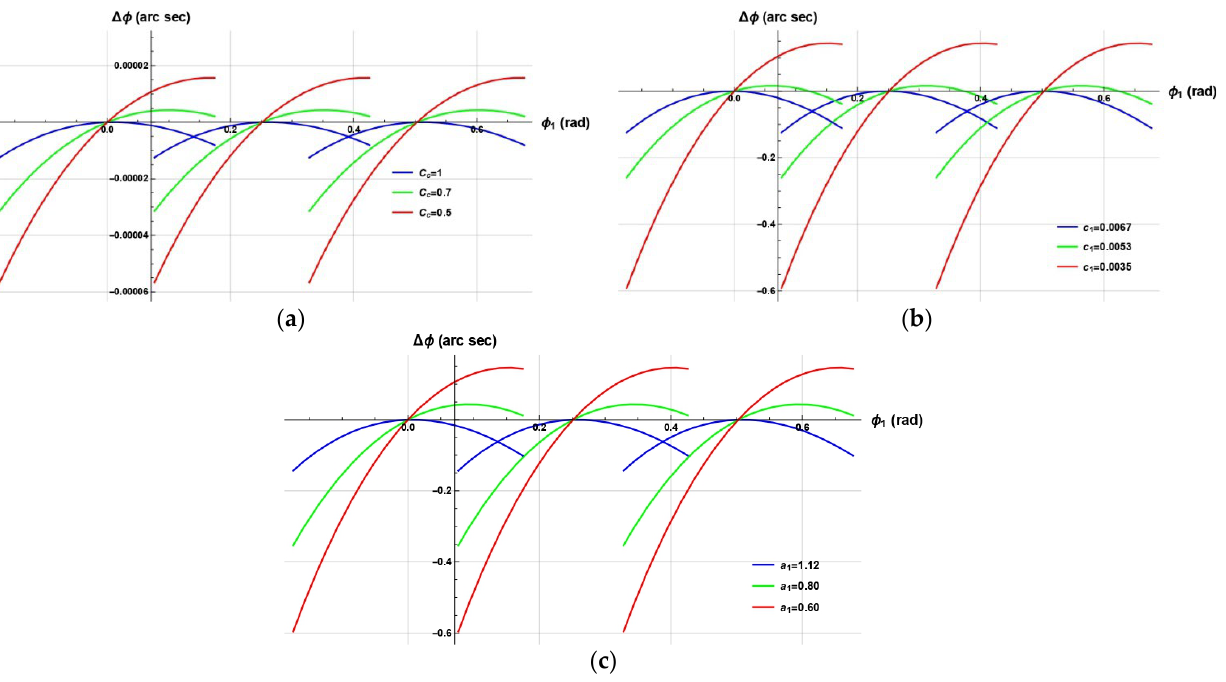
Figure 8. TE functions with different amounts of crowning: ( a ) circular, ( b ) parabolic, and ( c ) loga- rithmic.